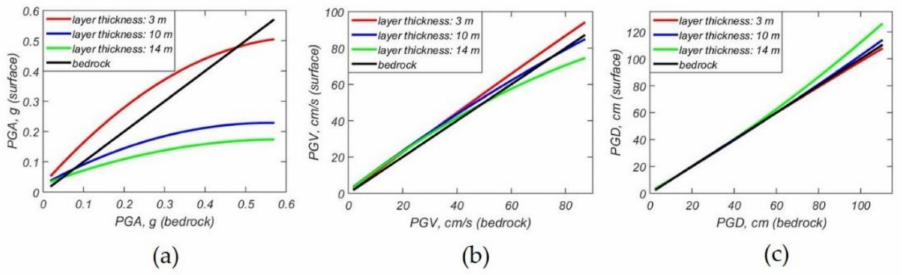
Figure 10. Modeled dependences (polynomial approximation) of peak ground acceleration (PGA) ( a ), peak ground velocities (PGV) ( b ) and peak ground displacements (PGD) ( c ) on the surface of the soft clay